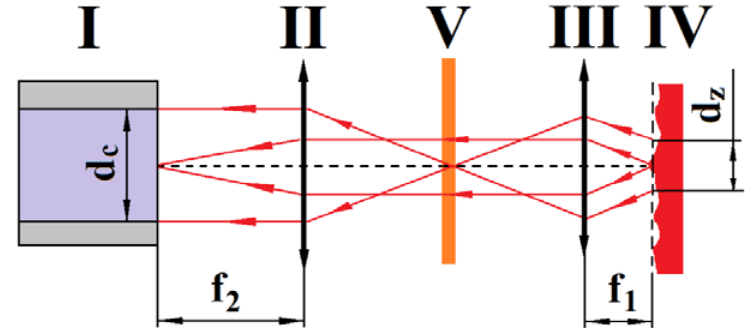
Figure 2. A diagram displaying the operation principle of the light-collecting unit (“A” in Figure 1); I—input tip of the fiber-optic patch-cord; II—lens; III—microscope objective (Nikon E plan 100X, N.A.1.25); IV—sample under study; V—pump = blocking filter (OG590).